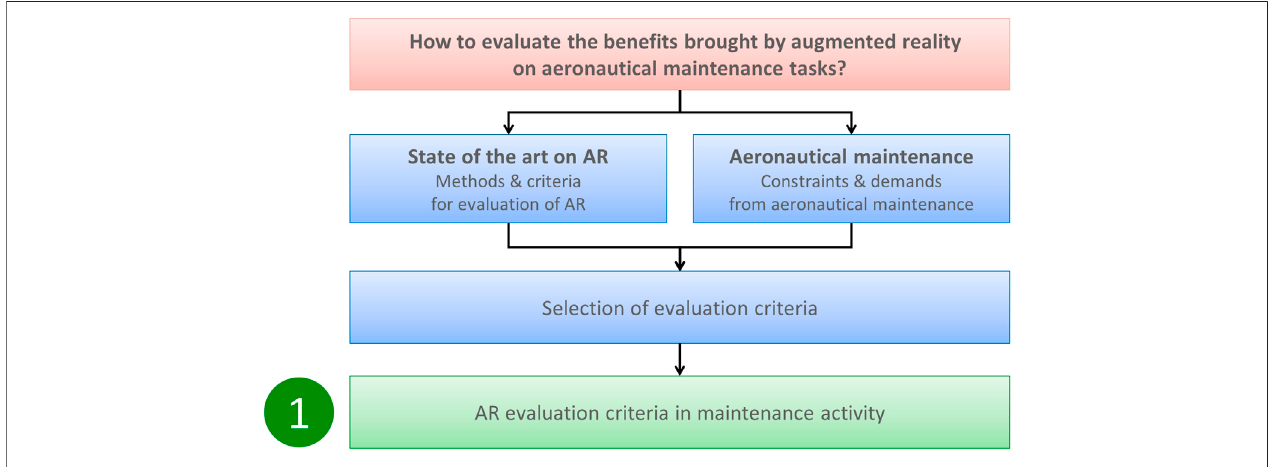
FIGURE 4 | Methodology to select criteria for evaluation of the impact of AR for aeronautical maintenance.